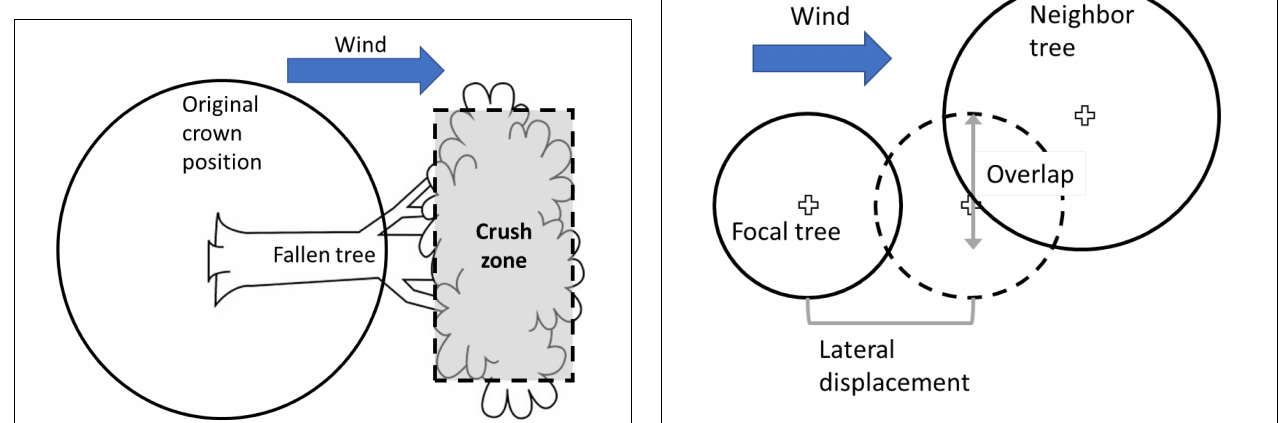
FIGURE 2 | Schematic illustration of the estimation of indirect damage caused by a large tree falling on a smaller neighbor. Crush zone is slightly smaller in the y dimension to allow for bending of outer branch tips of the falling tree.